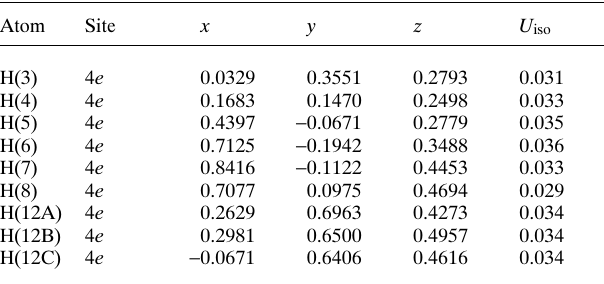
Table 2. Atomic coordinates and displacement parameters (in Å 2 ) .